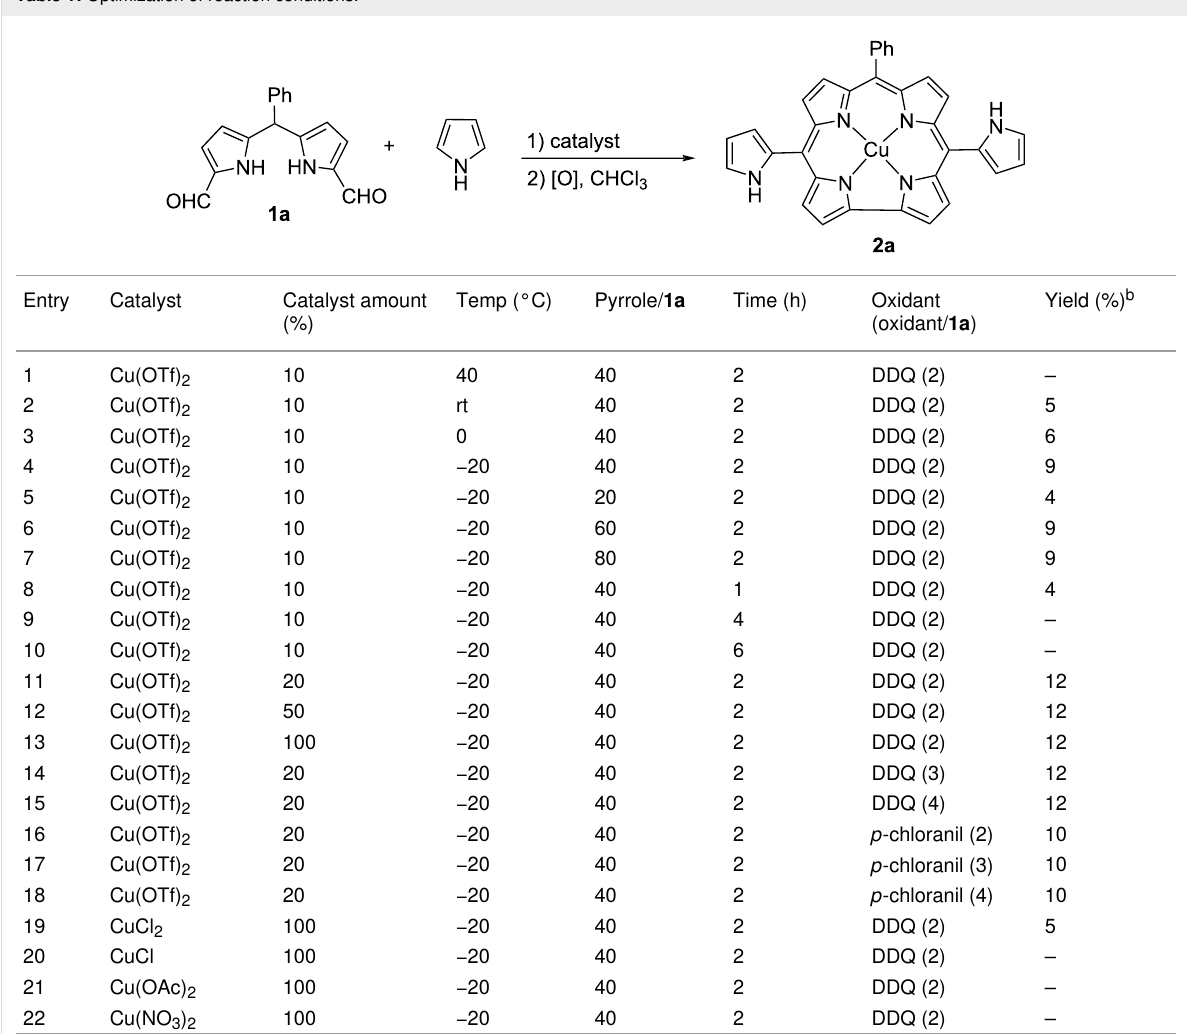
Table 1: Optimization of reaction conditions.